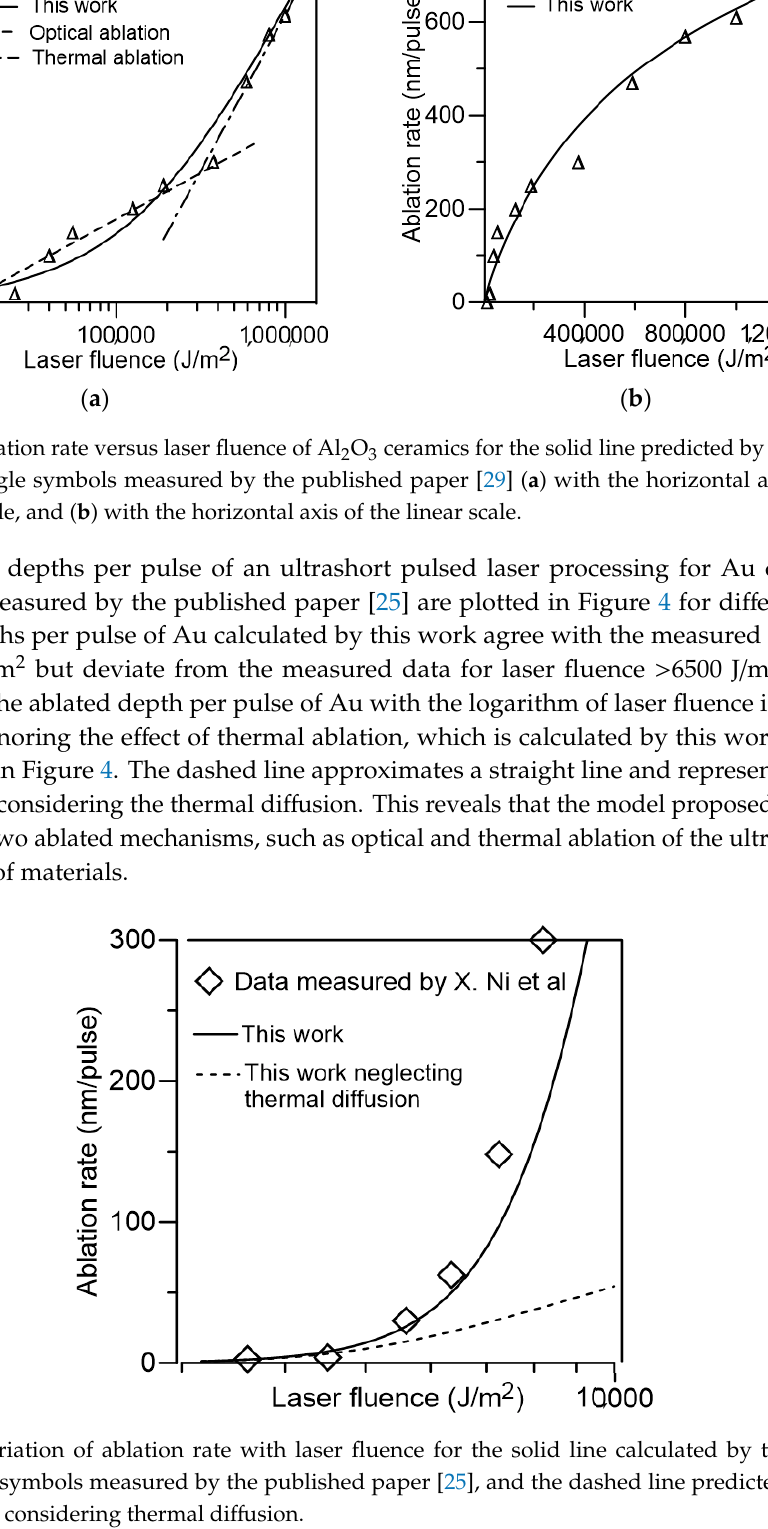
Figure 5. Moving rate of ablated interface versus time of optical ablation and thermal ablation for the bold line and bold dashed line with laser fluence 100,000 J/m 2 as well as the fine line and fine dashed line with laser fluence 10,000 J/m 2 . 4. Conclusions • The model proposed by this work can, respectively, divide the analysis of an ultrashort pulsed laser processing of materials into the optical and thermal effects using the Laplace transform;